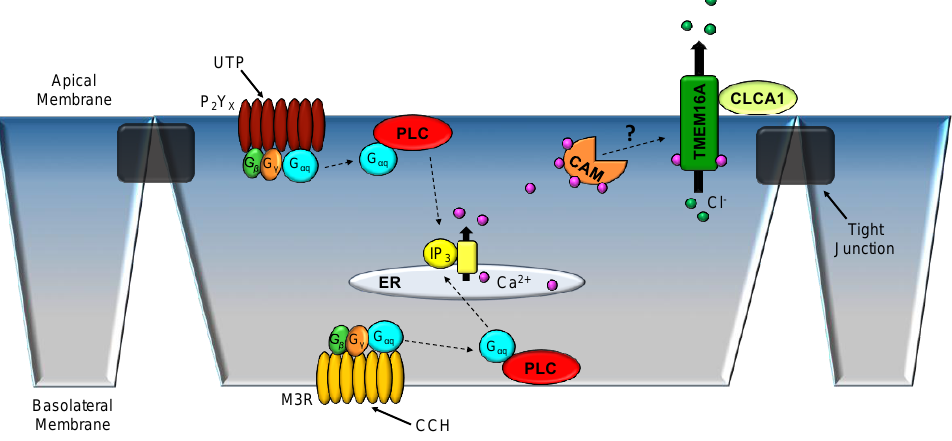
Figure 3. Cellular model of Ca 2+ -activated Cl − secretion in tracheal epithelium. Either apical ATP or basolateral carbachol (CCH; a muscarinic receptor (M3R) agonist) administration transiently increases intracellular Ca 2+ stores from endoplasmic reticulum (ER), leading to increased Ca 2+ -activated Cl − secretion through TMEM16A. G-protein (Gαq)-coupled receptors, including the apical P 2 Y X purinergic receptor (UTP) and basolateral M3R mediate the release of internal Ca 2+ stores. Either Ca 2+ -calmodulin (CAM) or the extracellular protease CLCA1 may modulate TMEM16A mediated Cl − secretion by activating the channel and/or increasing the plasma membrane expression. CLCA1—Cl − channel accessary-1; PLC—phospholipase C.